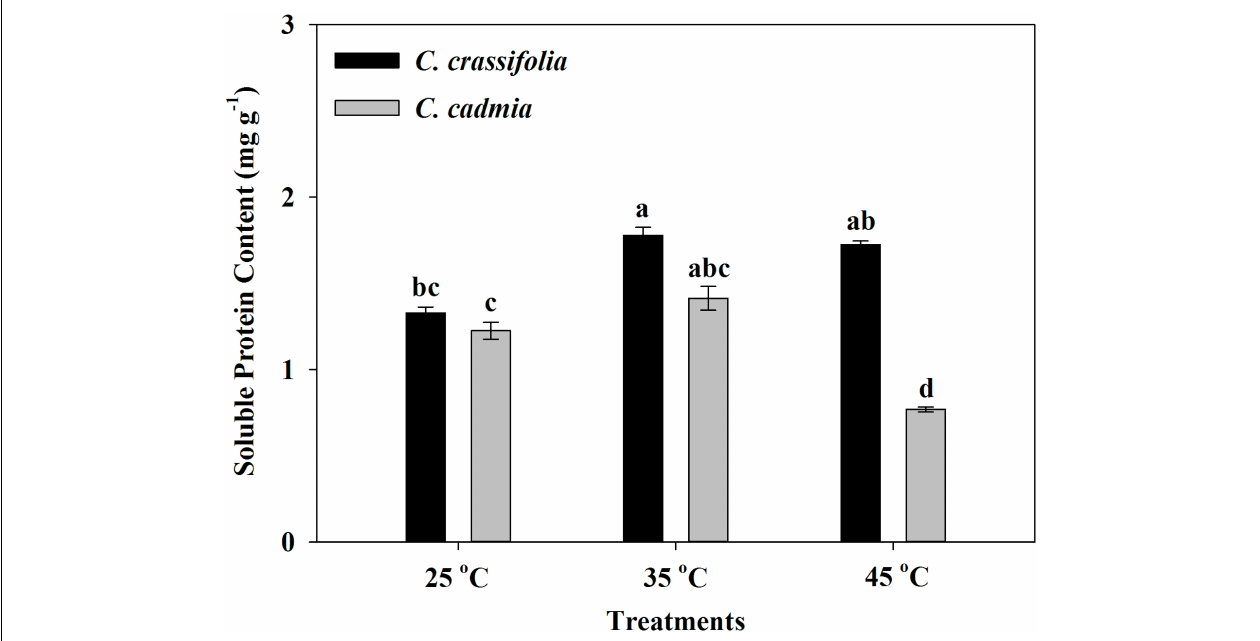
FIGURE 6 | Soluble protein content of C. crassifolia and C. cadmia grown under three different temperatures. Values are the means ± standard error ( n = 5 plants). Different letters indicate significant differences based on two-way ANOVA followed by Tukey multiple comparisons ( P ≤ 0.05).